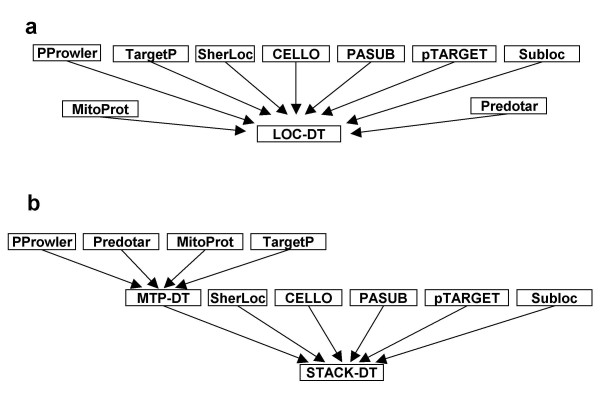
Integration of heterogeneous prediction tools by decision trees. a, The LOC-DT was built with outputs from nine LOC-tools. b, The MTP-DT was built with outputs from four tools whose prediction is based on the mitochondrial targeting peptide. The output of MTP-DT, together with the outputs of five other LOC-tools, was used to construct the STACK-DT.